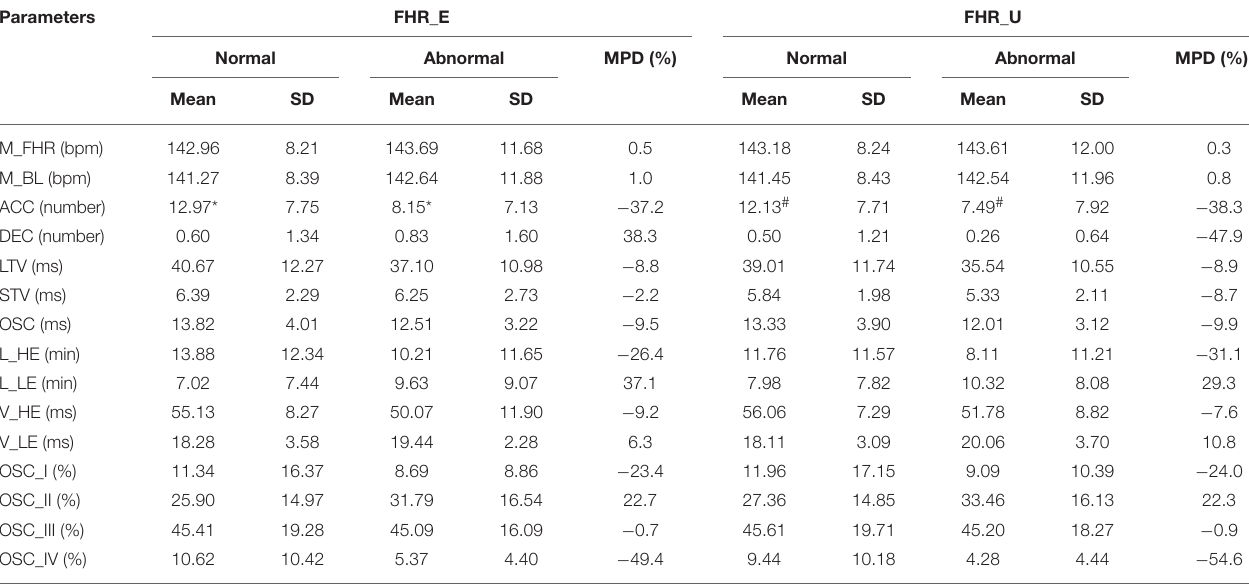
TABLE 5 | Summary of the FHR-E and FHR-U signal analysis comprising 15 clinical parameters determined using computer-aided fetal monitoring system, for two groups of fetal outcome, together with the mean percentage difference MPD depicting the inconsistencies between both the groups. Parameters